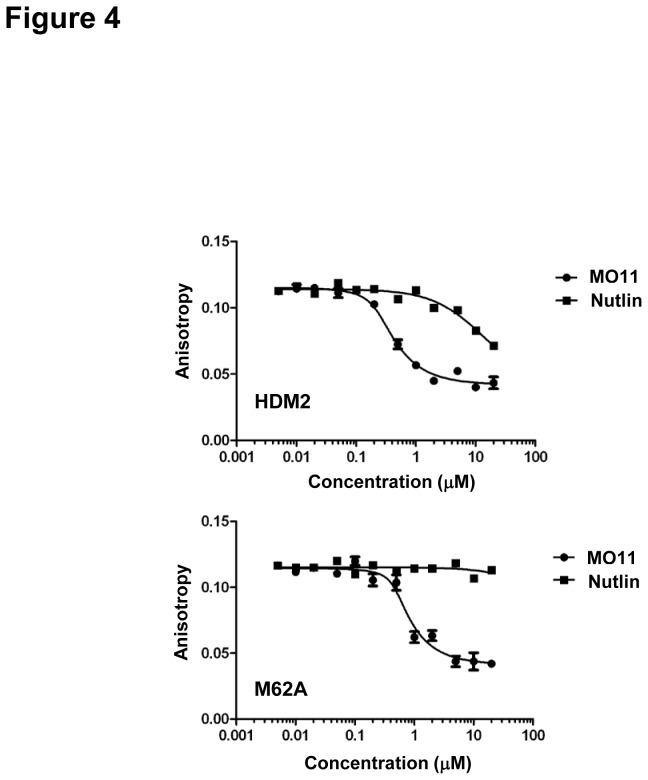
Differential binding of stapled peptide versus Nutlin to HDM2-M62A.Competition titrations of MO11 and Nutlin against FAM-labelled p53-binding peptide 12.1 for binding to wild-type (top) and M62A (bottom) HDM2 mutant. Values represent mean +/- SD (n=2).